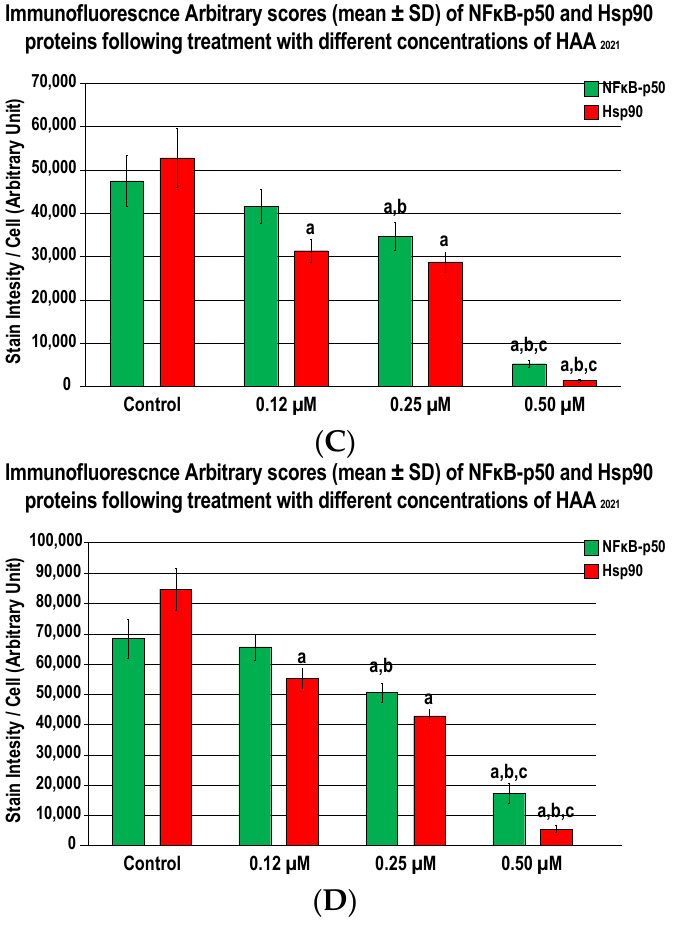
Figure 12. Double localization of NF- κ B (green) with Hsp90 α (red) by immunofluorescence in the MCF7 ( A ) and MCF7/ADR cells ( B ) following treatments with different concentrations of HAA 2021 for 72 h (40 × objective; scale bar = 10 µ m). Arbitrary scores of the immunofluorescent stain intensity/MCF7 cells ( C ) and MCF7/ADR cells ( D ) (mean ± SD) for each protein are shown as graph bars (a = p < 0.05 compared with the control untreated cells; b = p < 0.05 compared with the 0.12 µM treatment; and c = p < 0.05 compared with the 0.25 µM treatment).